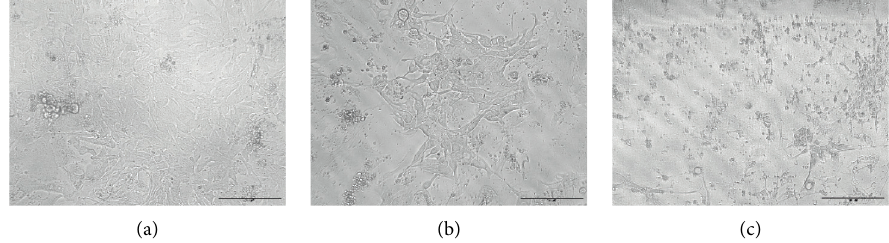
Figure 1: Primary liver cancer cells of control and test groups under the microscope. (a) Control group. (b) Inhibition rate: about 50%. (c) Inhibition rate: about